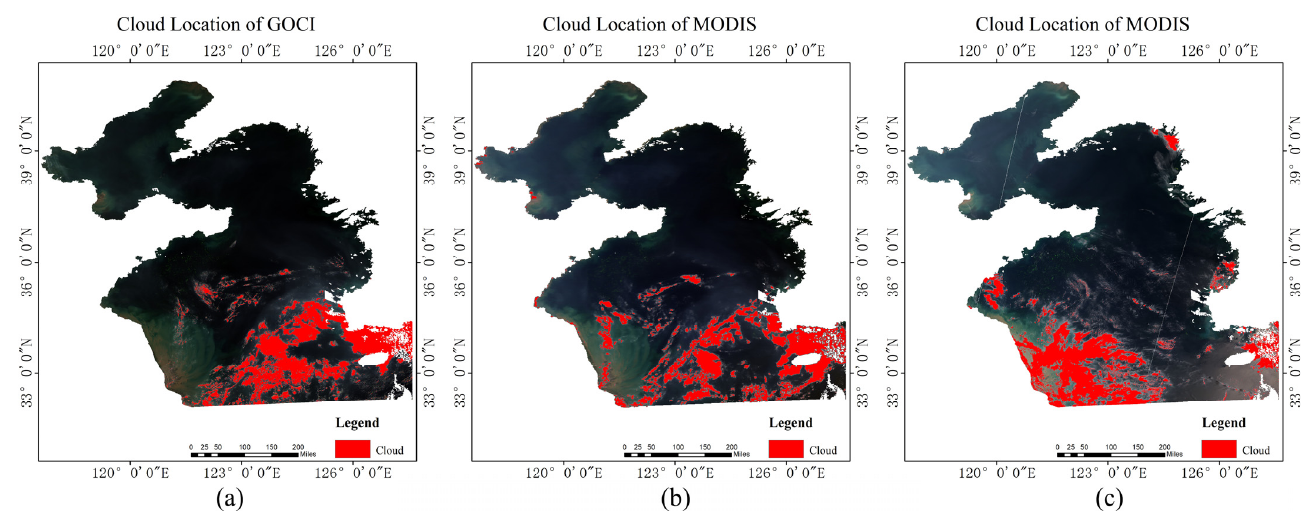
Figure 5. Cloud detection results and spatial location determination: ( a ) GOCI, ( b ) MODIS and ( c ) OLCI.